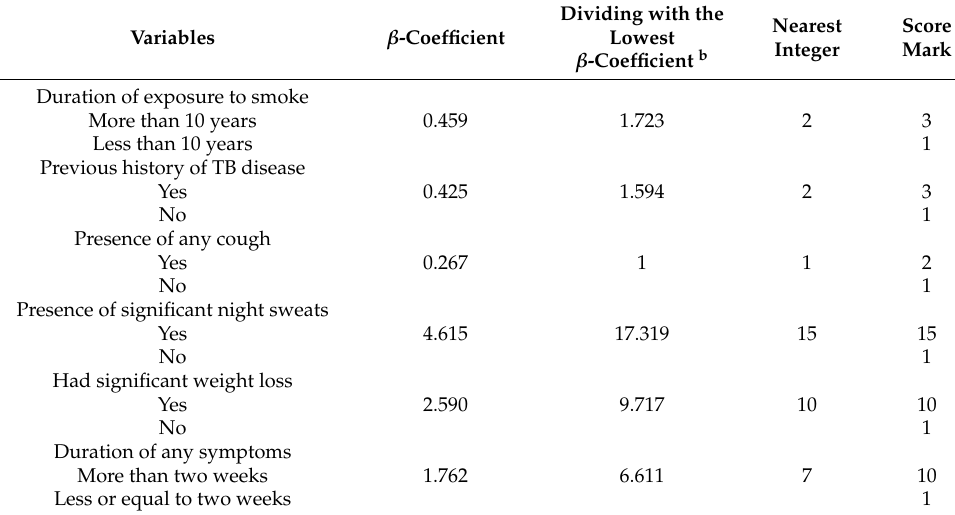
b The lowest β coefficient is the β coefficient for cough, β = 0.267.